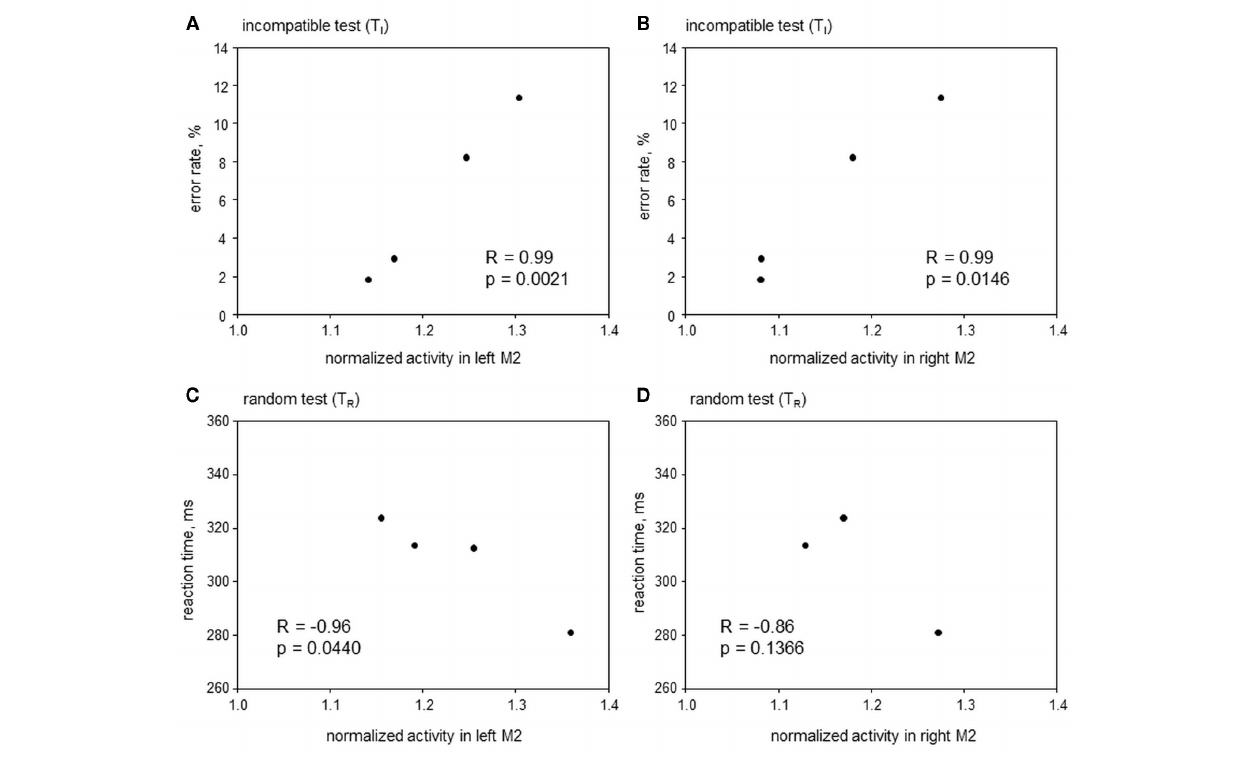
activity in the left (A,C) and right (B,D) anterior premotor cortex (aM2) of four animals. Significant correlations were found in (A–C)